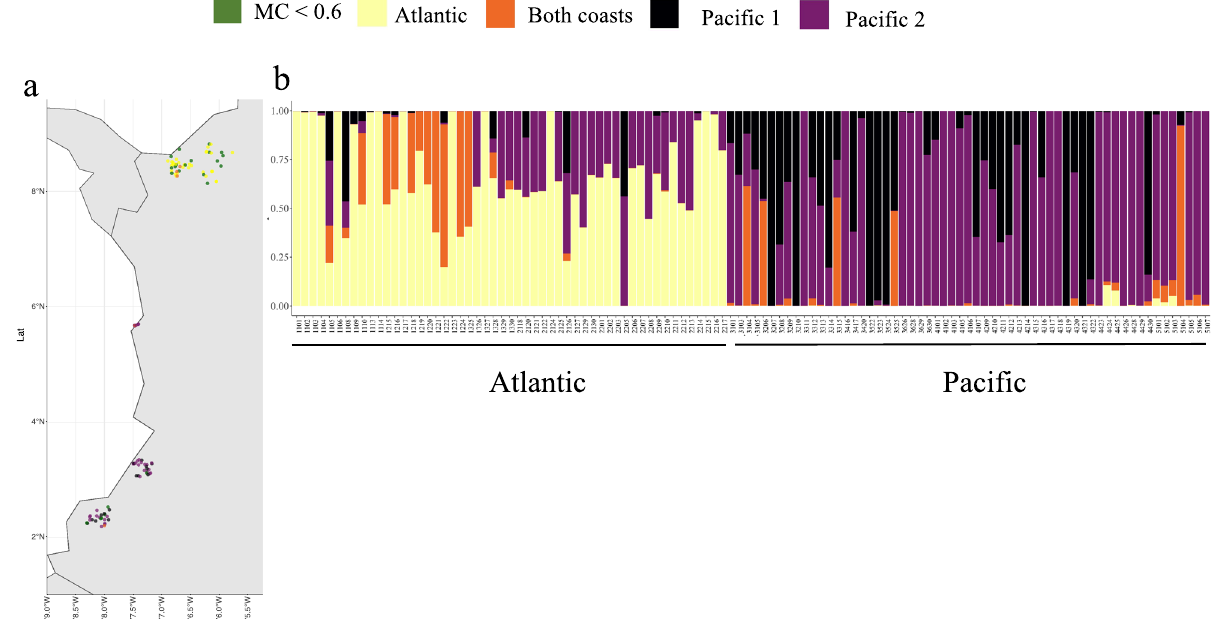
Figure 3. Analysis of the population structure using 112 accessions belonging to the Colombian coconut diversity panel. ( a ) distribution of genotypes along each Colombian coast. ( b ) Structure analysis with K = 4